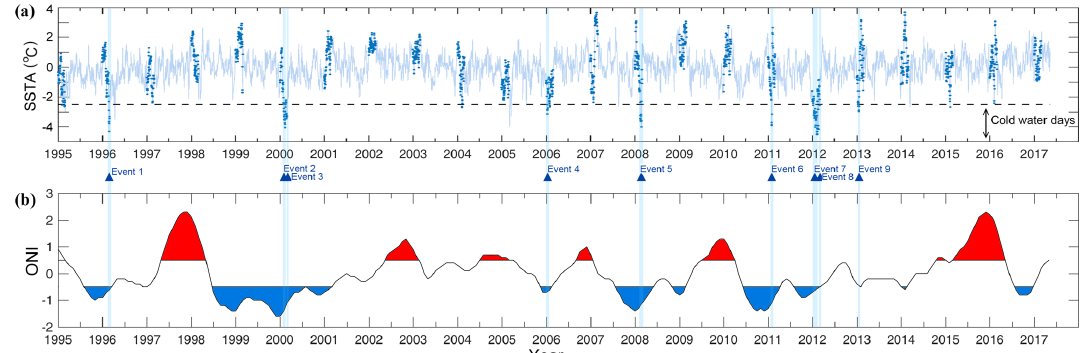
Figure 2. (a) Time series of SSTAs (shading line) and that during the winter days are highlighted in dots. The dashed line denotes a magnitude of 1.6 times the standard deviation below the mean SSTA. (b) ONI time series within January 1995 and May 2017. Positive anomalies ( ≥ 0.5 ◦ C, shaded red) indicate El Niño events, and negative anomalies ( ≤− 0 . 5 ◦ C, shaded blue) indicate La Niña events. Blue bars and triangles denote the occurrences of cold